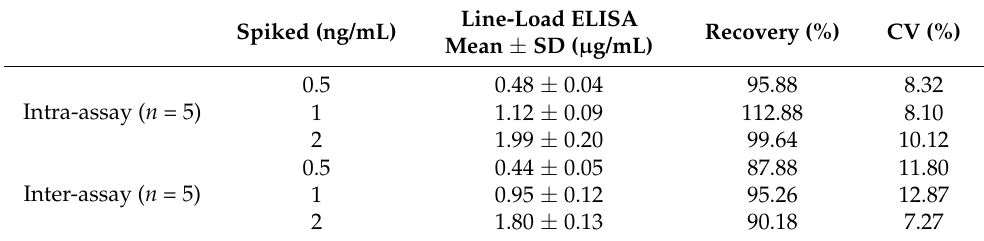
Table 2. Evaluation of line-load ELISA detection